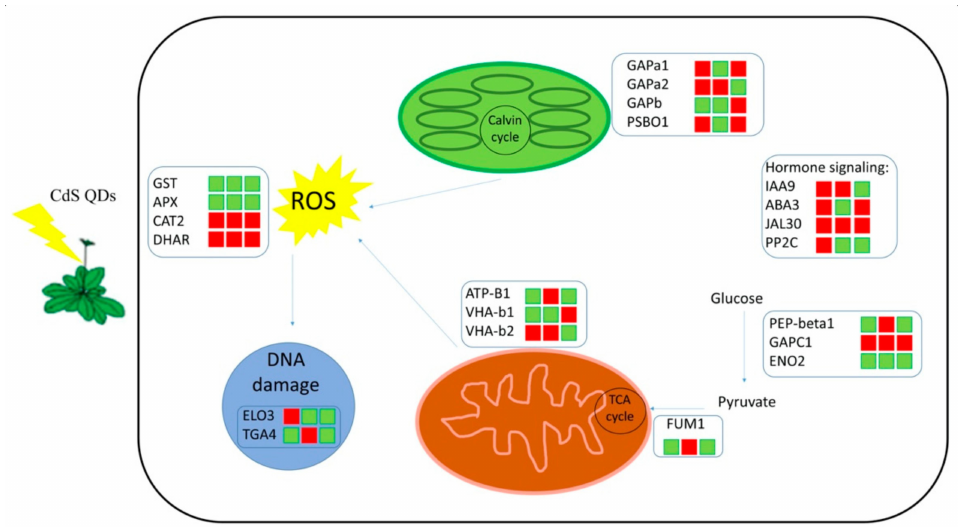
Figure 5. Model depicting the main A. thaliana proteome pathways responsive to CdS QDs treatment. For each protein the colored bars indicate up- (red) or downregulation (green). The first column indicates the up- and downregulated proteins in wt, while the second and third columns similarly show those in mutants atnp 01 and atnp